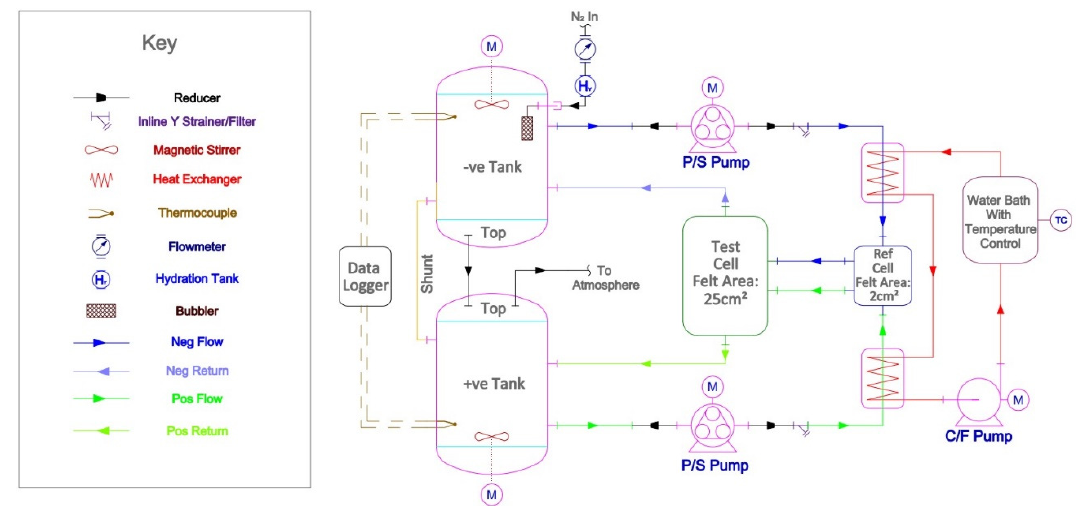
Figure 1. Schematic representation of the test-rig used in this study. Note that the test cell voltage, reference cell voltage and thermocouple outputs were recorded by the battery cycler, which additionally supplied current to the test cell. “Shunt” in this diagram refers to the hydraulic shunt between tanks.